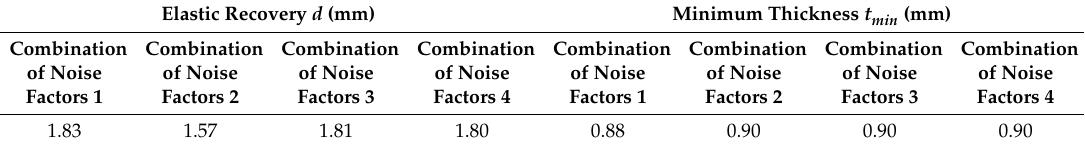
Figure 7. Main e ff ects diagrams: ( a ) main e ff ects for SN of the optimization function; and ( b ) main e ff ects for the mean of the optimization function. Table 6. Results of elastic recovery and thinning obtained with the optimal values of control